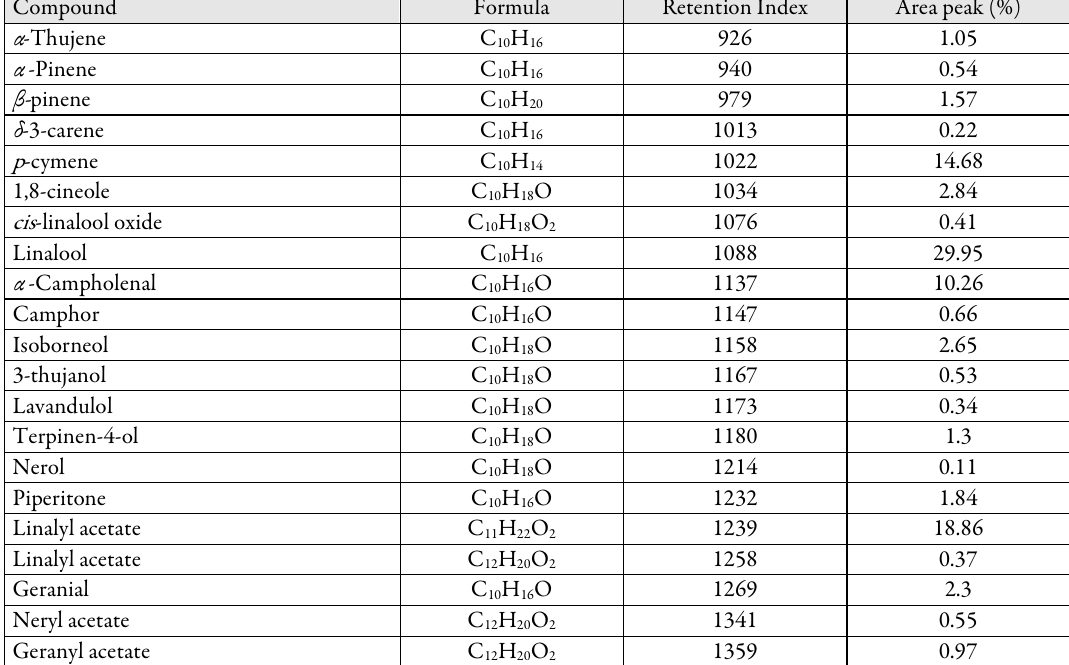
Table 3. Main components of L. angustifolia essential oil along with their Retention Index (RI) Compound